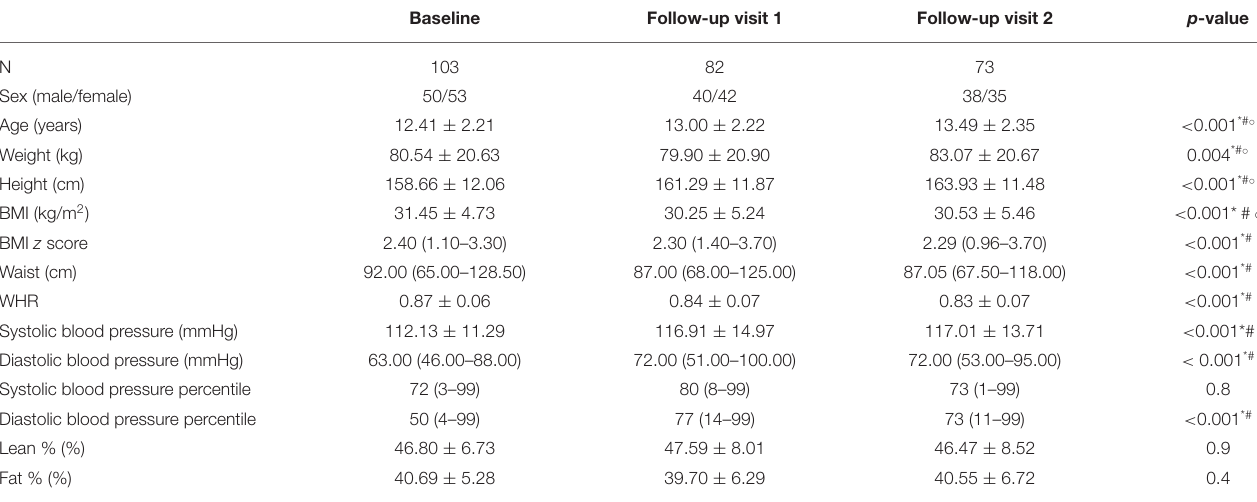
TABLE 4 | Patient characteristics and body composition measurements of baseline and follow-up visits. Baseline Follow-up visit 1 Follow-up visit